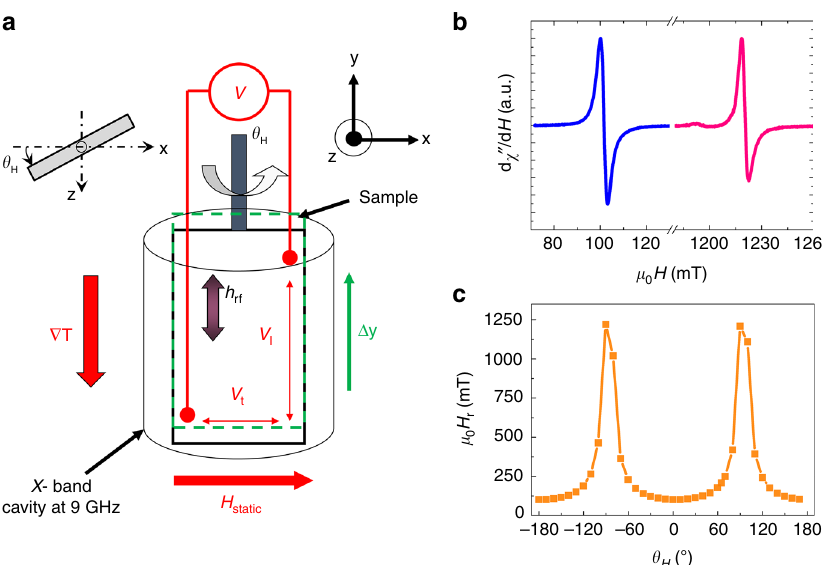
Fig. 3 FMR and voltage measurements. a Schematic of the spin-pumping experiment in the FMR cavity where the sample is vertically shifted Δ y ¼ 1 mm away from the cavity center. b Typical FMR spectra recorded at θ H ¼ 0 (cid:4) and 90 (cid:4) and c angular dependence of the resonance magnetic fi eld of the stack Al/NiFe/Al/WSe 2